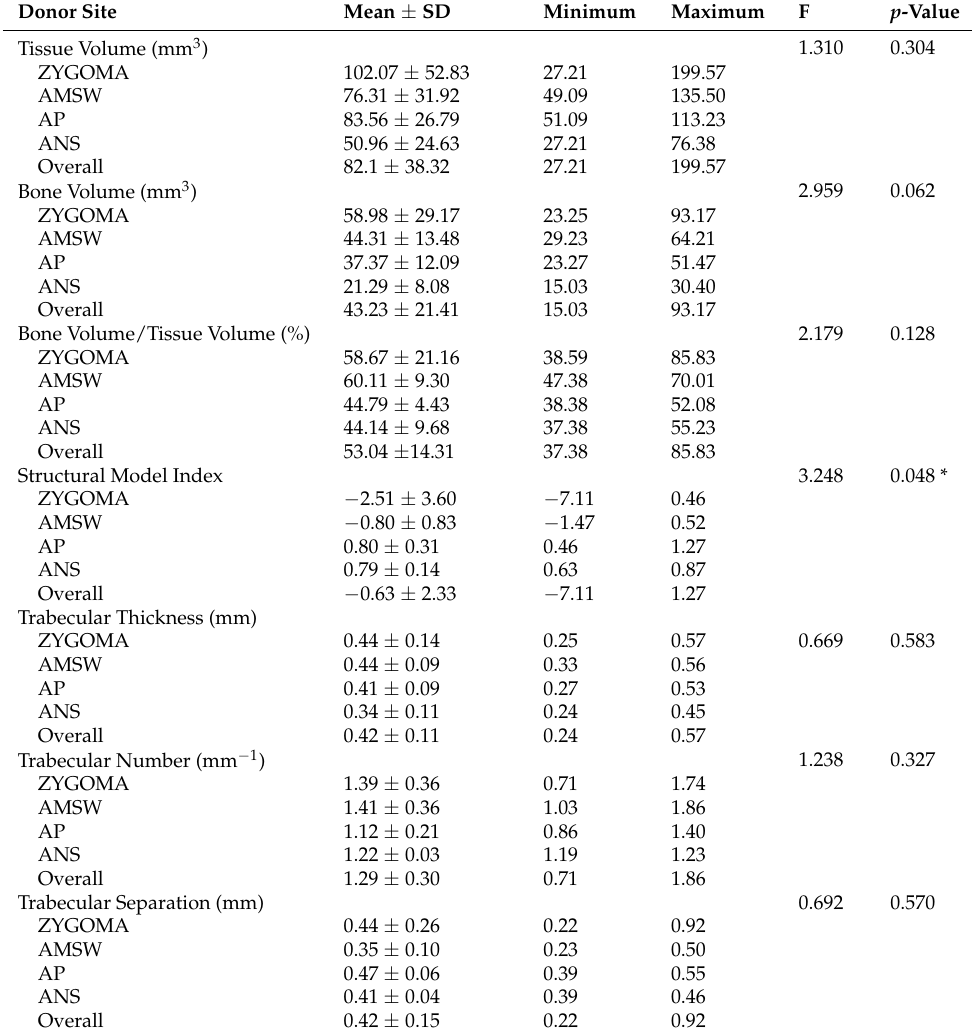
Table 2. Comparison of parameters between bone grafts taken from different donor sites ( n =